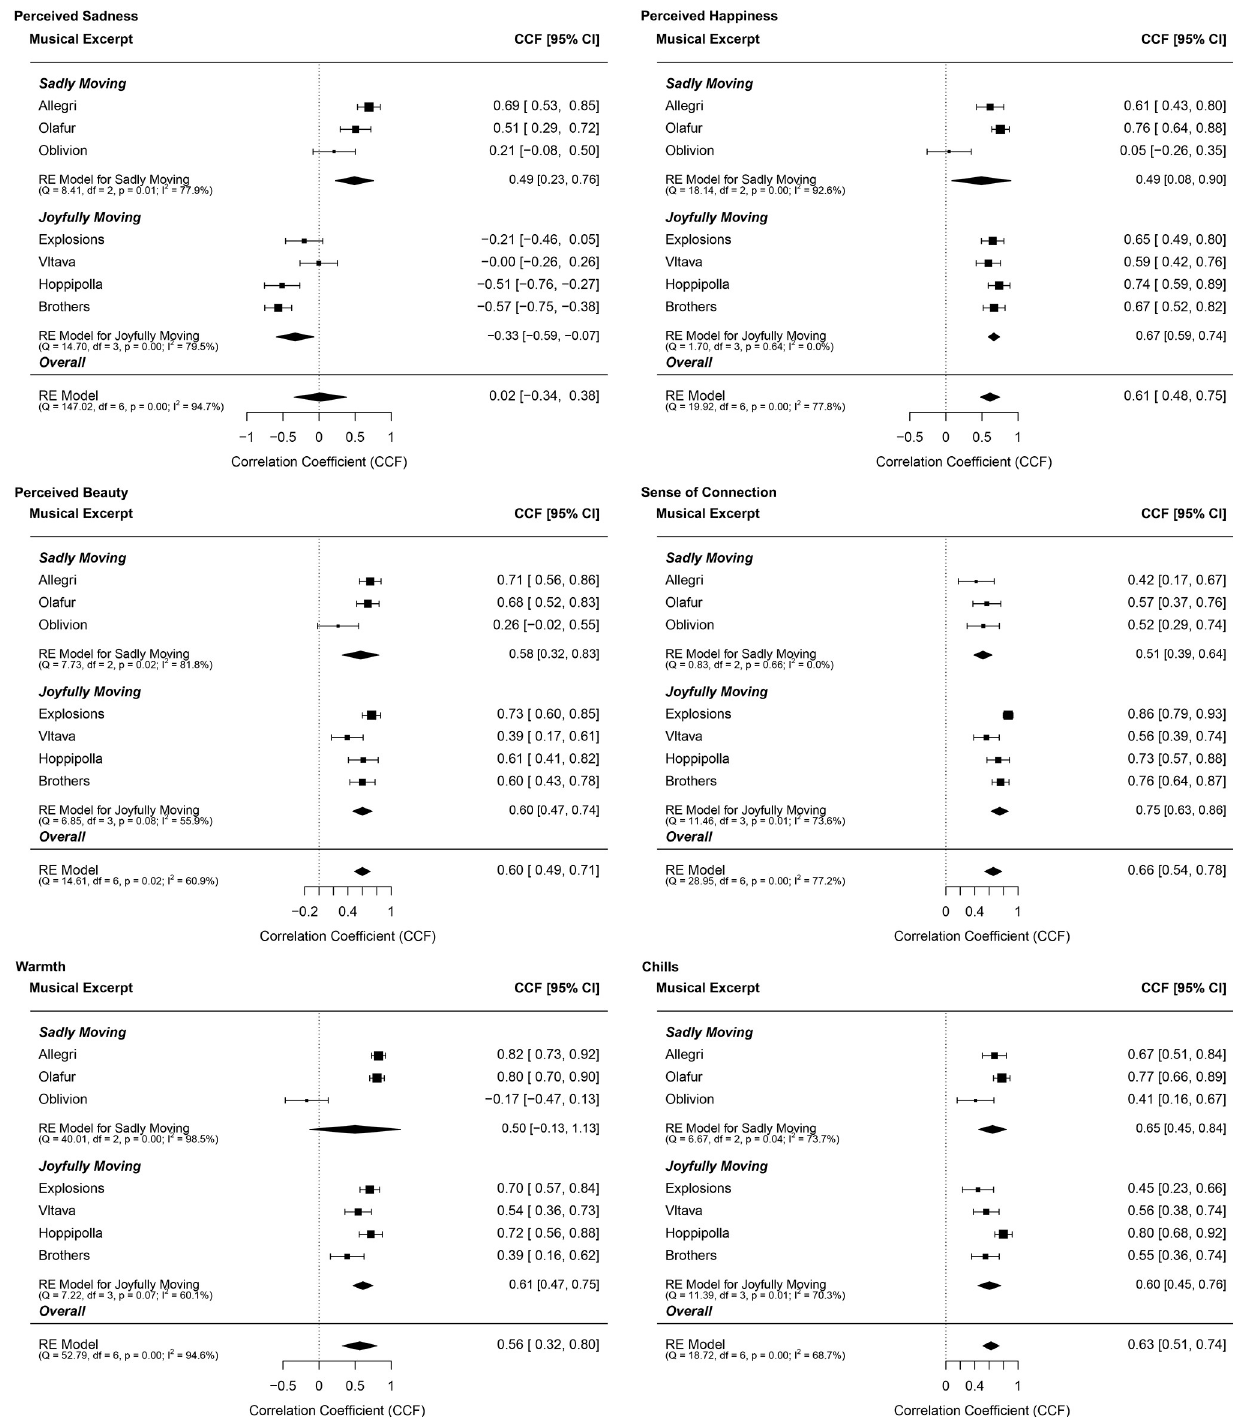
Fig 2. Cross-correlation functions (CCF) between feeling moved and touched and the six main variables across the musical excerpts. CCFs were calculated at lag 0 (meaning that both time series are compared at the same time) using cubic spline detrended timeseries. Sadly and joyfully moving songs are grouped separately. Overall estimates and confidence intervals are constructed employing a random-effects meta-analysis using restricted maximum likelihood estimation. Error bars represent 95% confidence intervals. RE = random effects. As heterogeneity measures we included Cochran’s Q and I 2 .